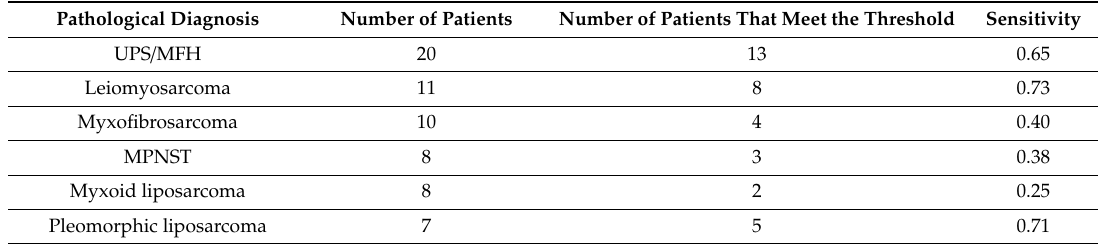
Table 8. Number of patients that meet the threshold by pathological